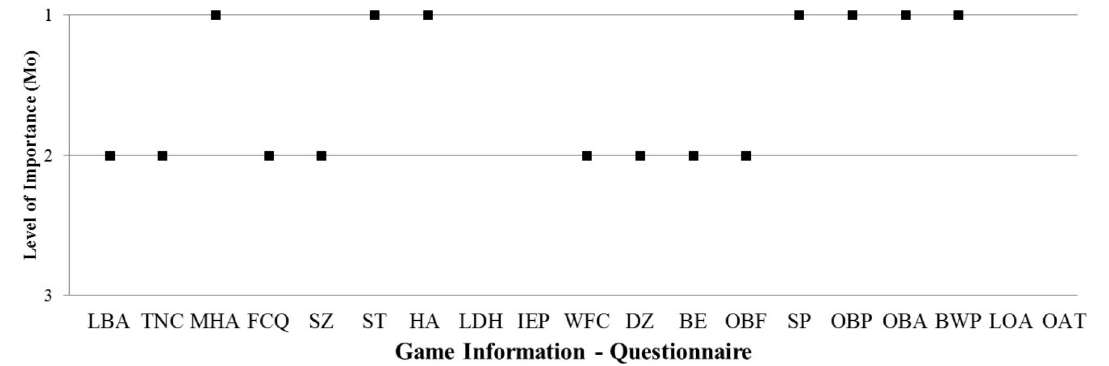
Figure 4: Mode values of each of the game information encountered by the setters during the Counter Attack Processes contained in the questionnaire.